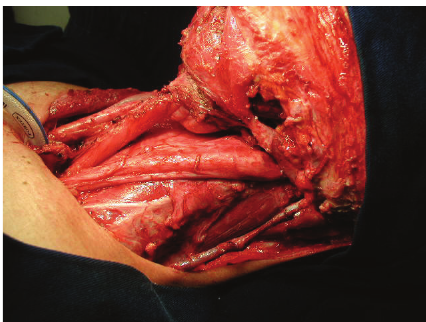
Figure 1: Left radical neck dissection with preservation of the left external jugular vein (EJV).